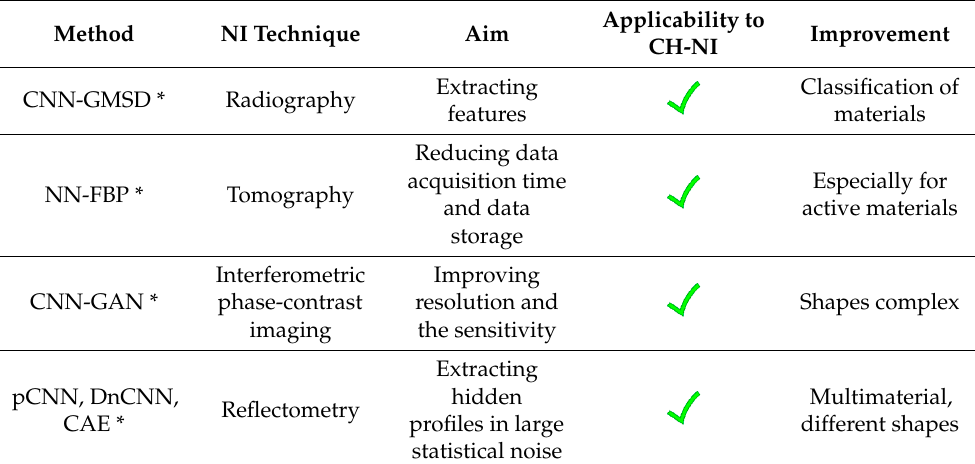
Table 4. Deep Learning algorithms used in different Neutron Imaging techniques are listed, with their usability and the corresponding Neutron Imaging in cultural heritage applicability with the improvement in the field.